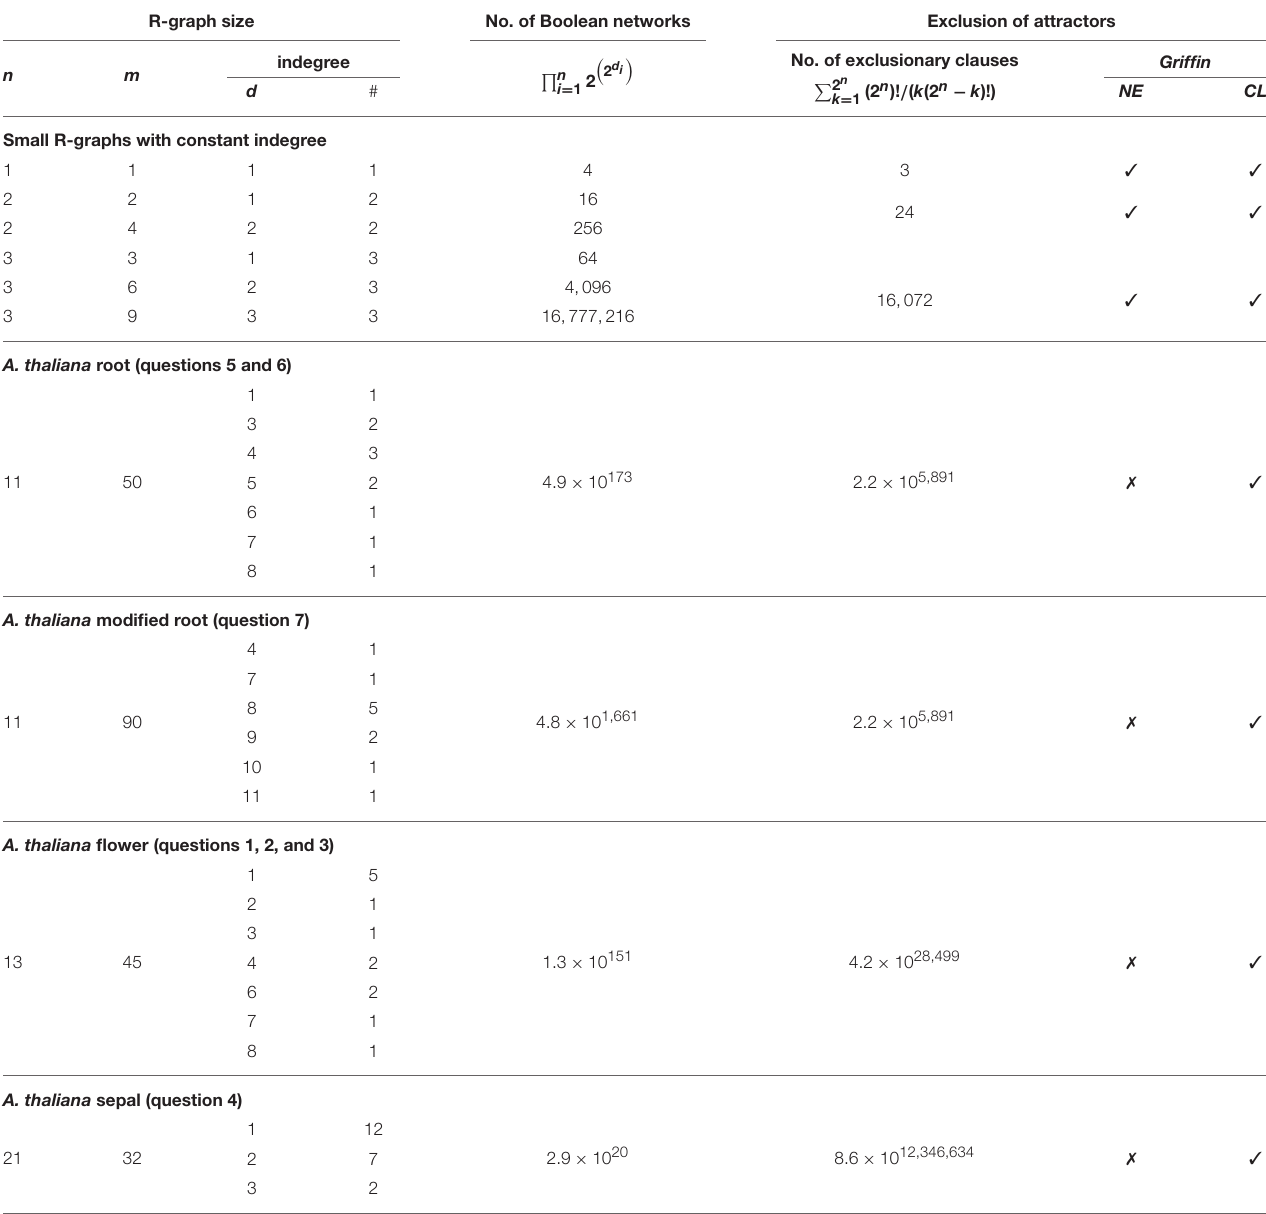
TABLE 2 | Scalability increase through clause learning in Griffin . R-graph size No. of Boolean networks Exclusion of attractors